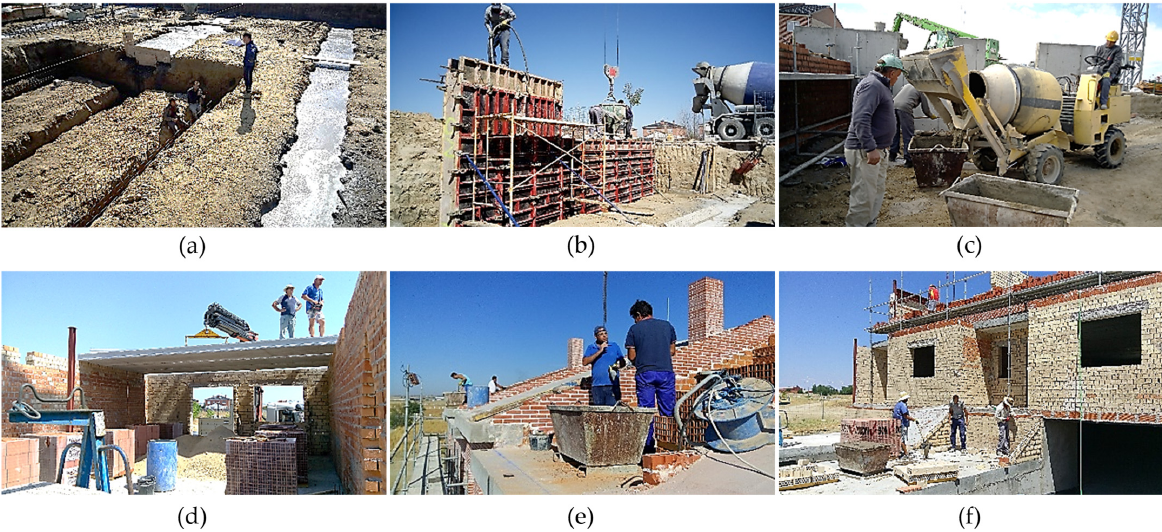
Figure 4. Different moments in the construction process of the building: ( a ) Foundation; ( b ) Reinforced Concrete Walls; ( c ) Urbanisation; ( d ) Precast Slabs; ( e ) Roofs; ( f ) Facades.